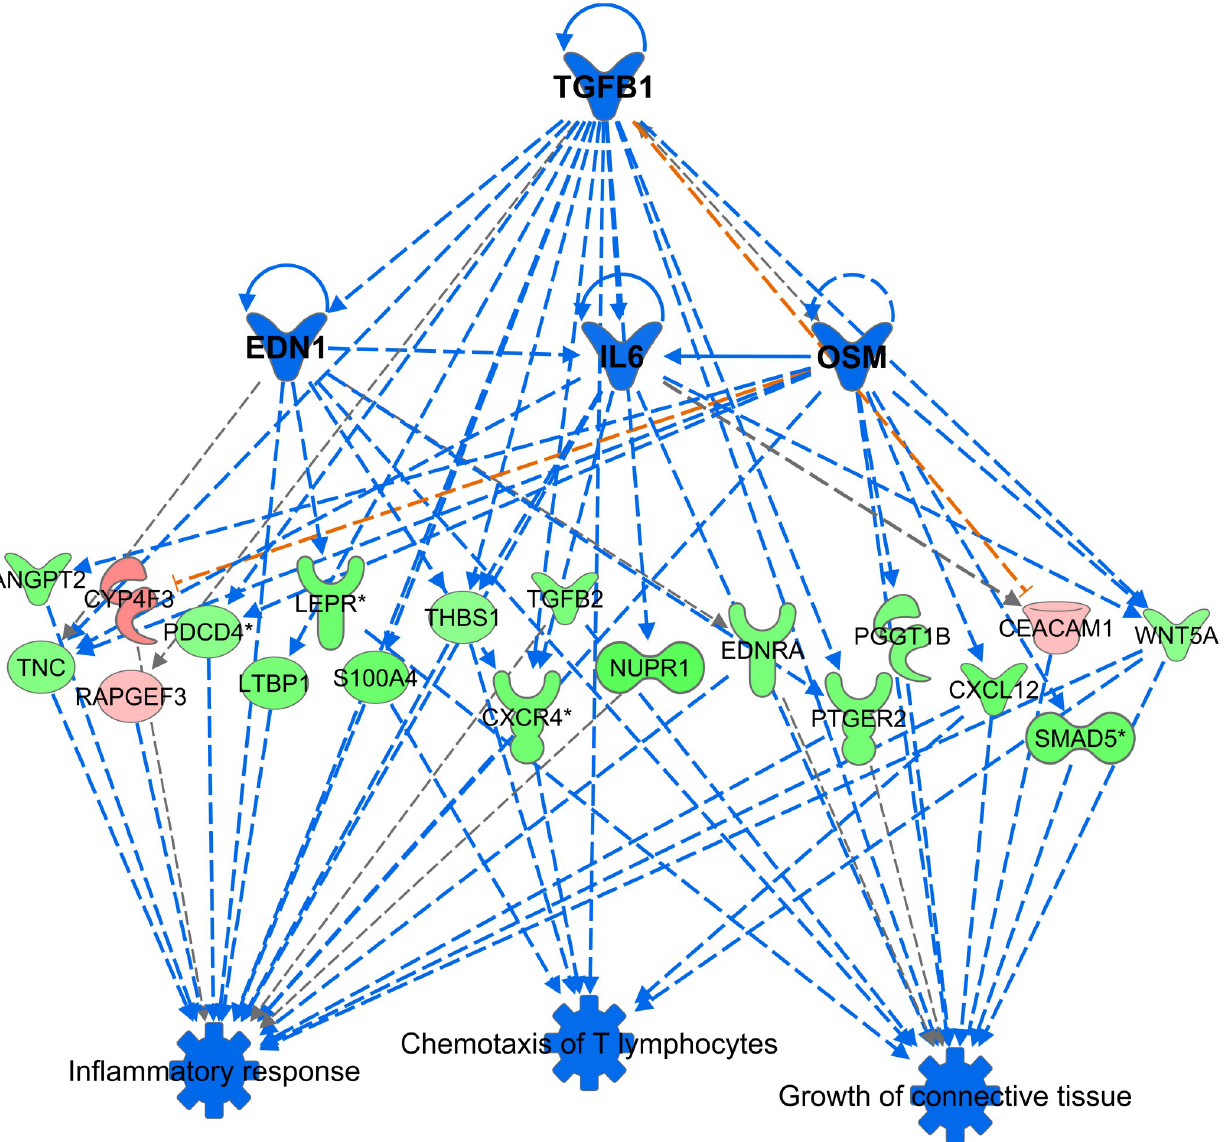
Fig 7. Predicted upstream regulators. Based on the differentially expressed genes, certain functions like inflammatory response, chemotaxis of T lymphocytes, and growth of connective tissue were predicted to be inhibited (blue). IPA analysis predicted that the inhibition of upstream regulators like the cytokine TGFB1, EDN1, IL-6 and OSM would lead to decrease in the functions listed in the third tier of the figure via their effect on the mediator genes that were also seen to be differentially expressed between the two groups. Please see Table H in S5 File for complete information.